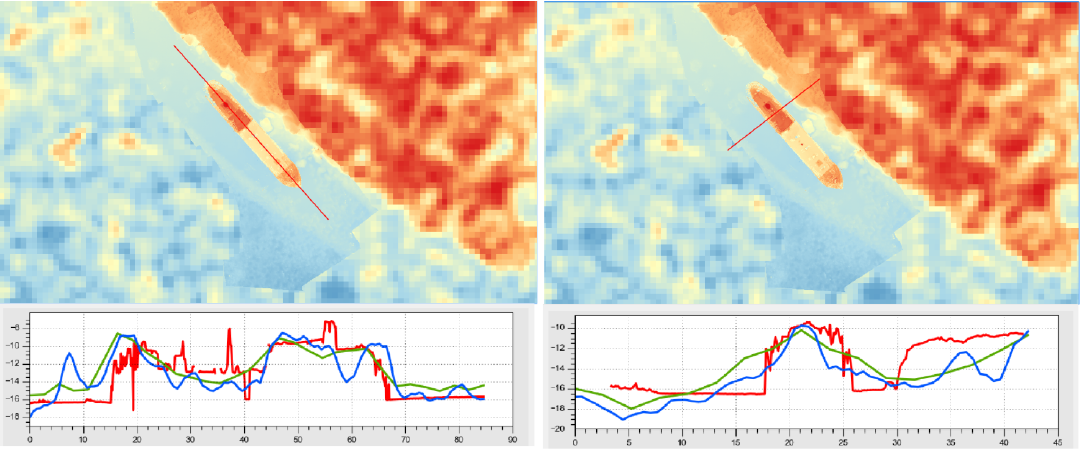
Figure 17: Two examples of bathymetry transects over the Elphis I wreck. Red line represents bathymetry derived with sonar measurements, green line bathymetry derived with WorldView-2 data with a resolution of 2.0 m, while blue line represents bathymetry derived with pan-sharpened data with a resolution of 0.5 m. Maps show sonar bathymetry of Elphis I wreck over- laid on satellite bathymetry of the surrounding